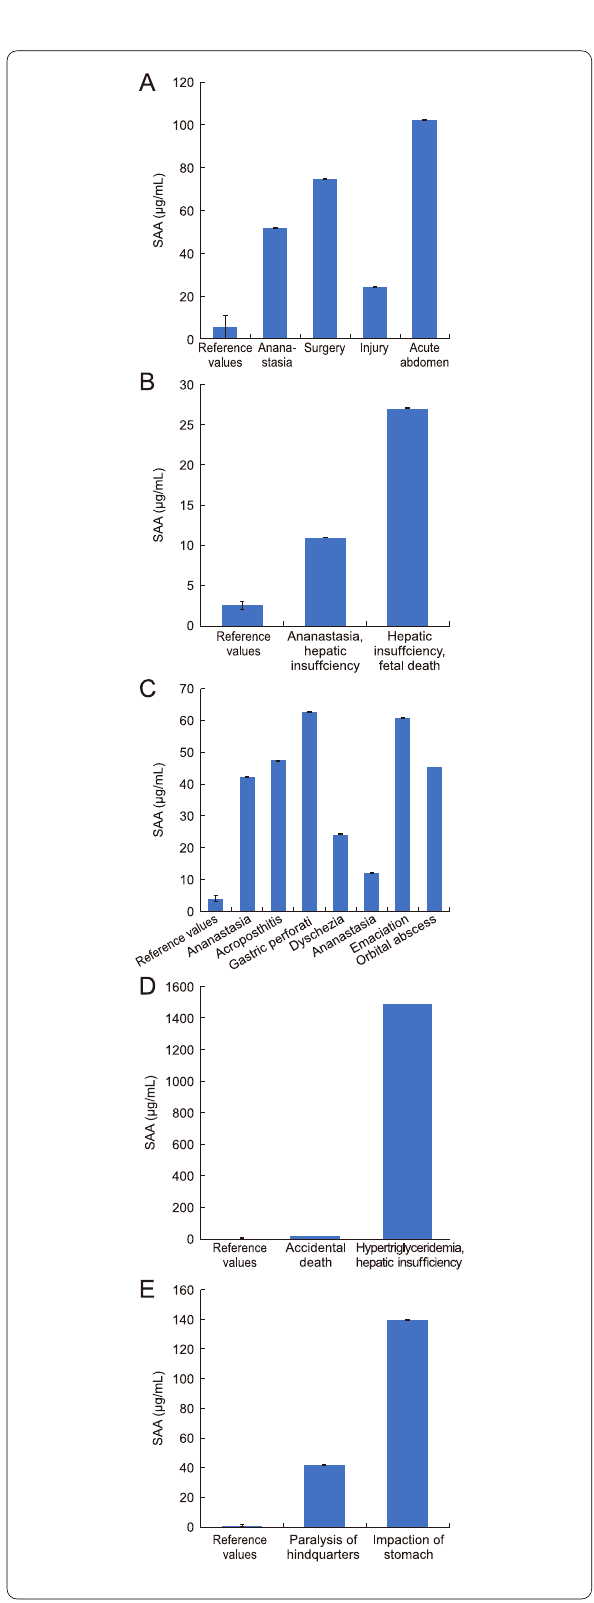
5.65 μg/mL ( n 8). B Wild water ± = 0.50 μg/mL ( n 2). ± = 0.83 μg/mL ( n ± = 0.43 μg/mL, the author’s previous data ± 0.30 μg/mL ±